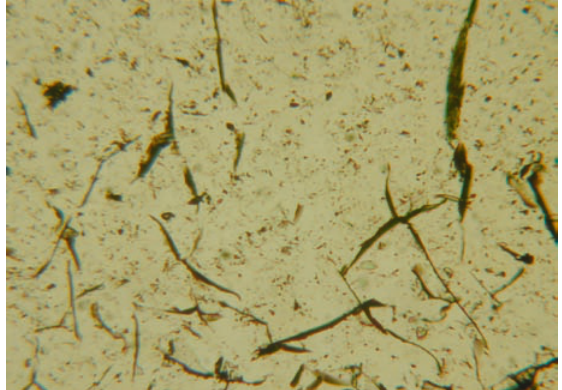
Figure 1. Surface cracks in Romanite, NII, 20x/0.33